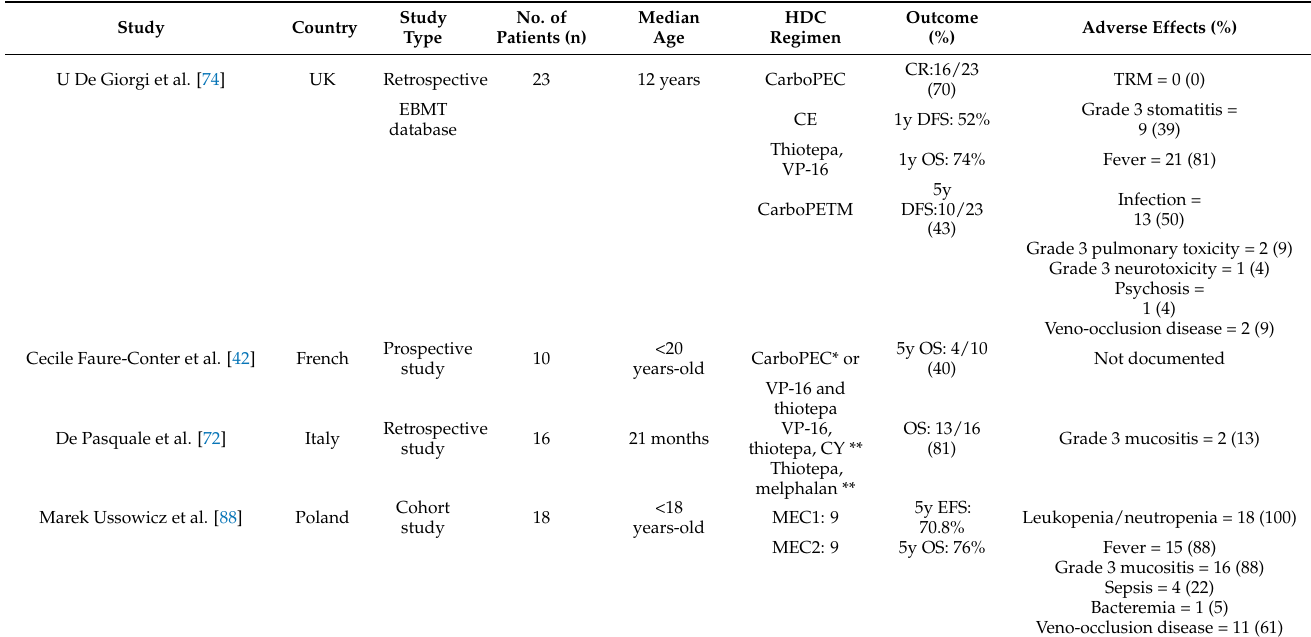
Table 2. Studies summarizing conditioning regimen for malignant germ cell tumors